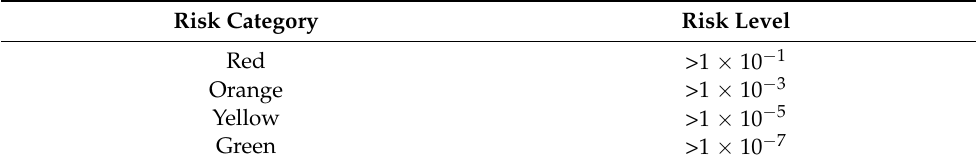
Figure A1. Iso-contours of equal risk. Table A6. Assigned risk categories to iso-contour risk levels.